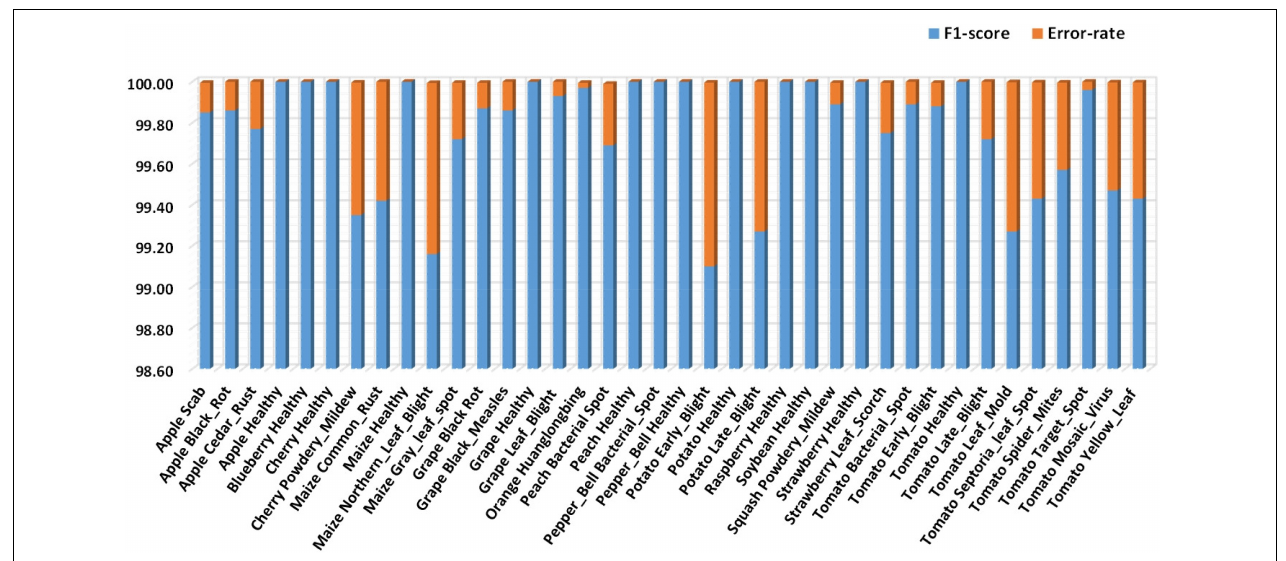
FIGURE 8 | Class-wise F1-score and error